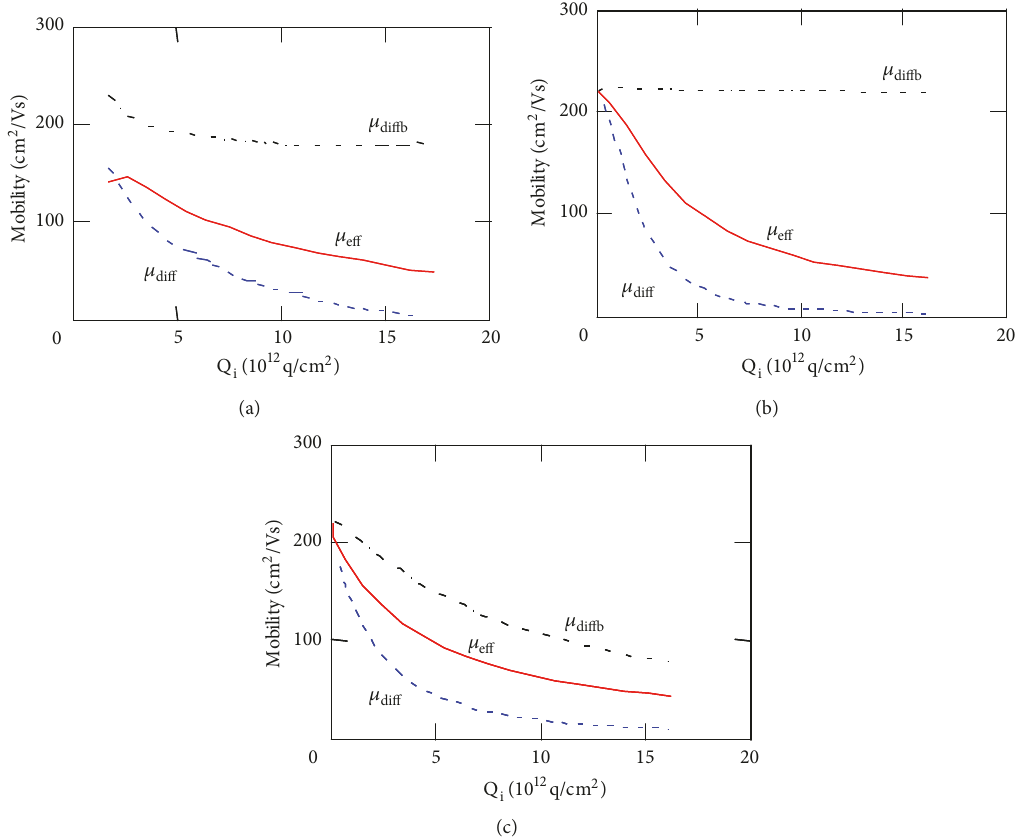
Figure 2: Variations of 𝜇 global (c) approaches ( 𝜇 0 = 220 cm 2 /Vs, E